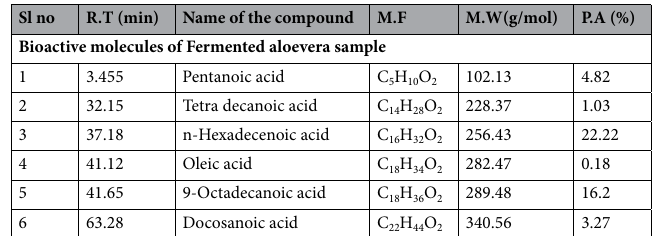
Table 6. Phytochemical components of hibiscus rosasinensus ethyl acetate fraction by GC–MS.